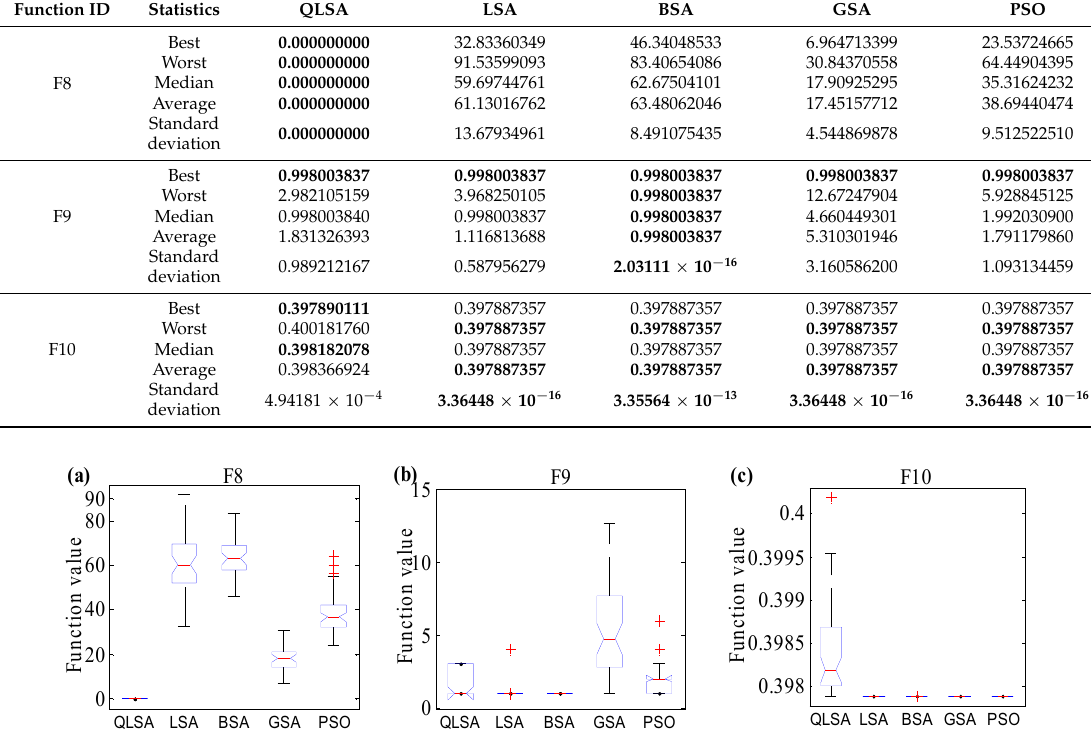
Figure 11. Variation in global optimization results for benchmark functions in Table 6. ( a ) F8; ( b ) F9; ( c ) F10.